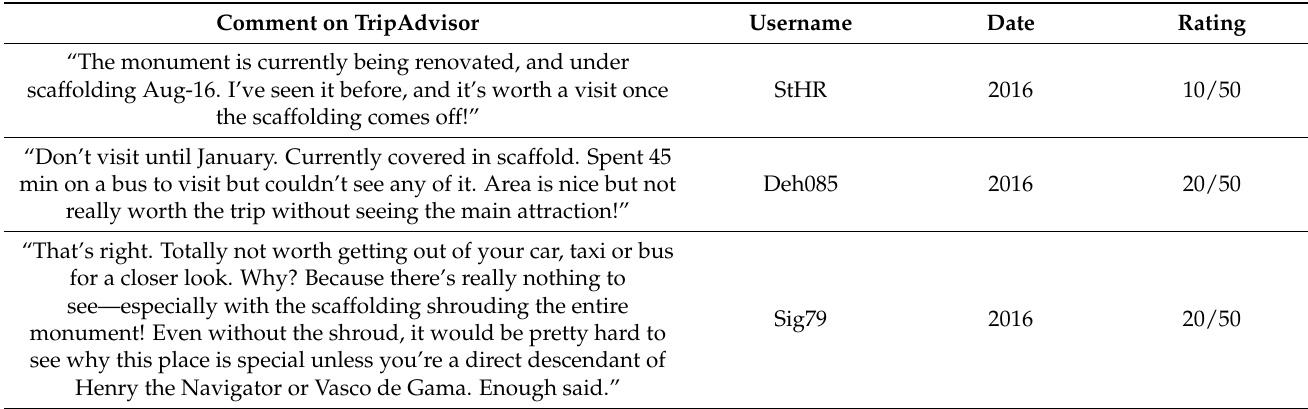
Table 4. Quotations regarding negative ratings due the maintenance actions carried out in the